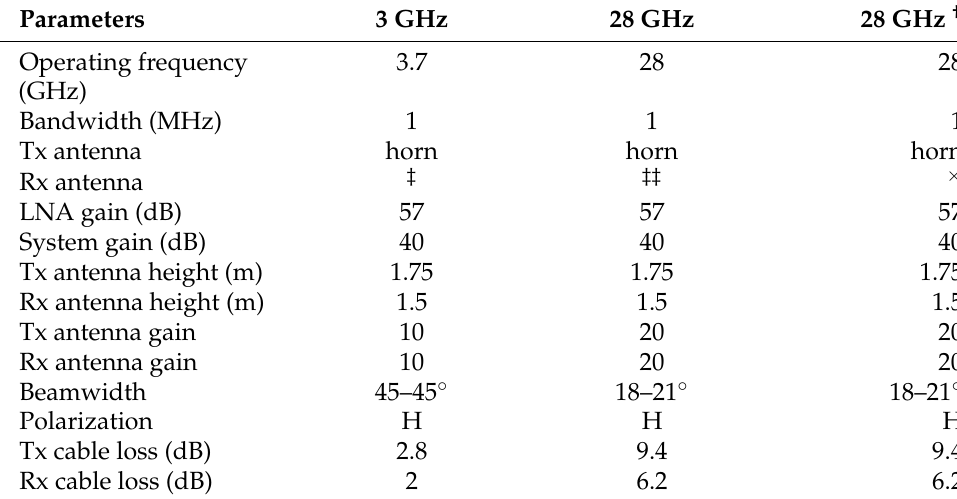
Table 2. Parameter specifications of the